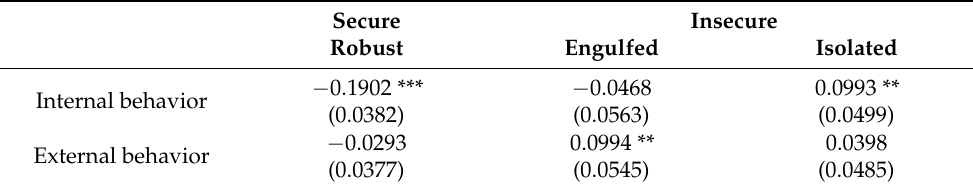
Table 4. Relationship between student’s behavior and students’